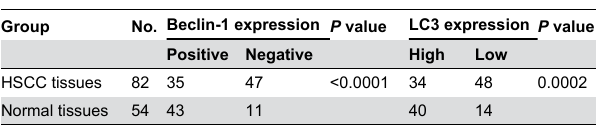
Table 2. Expression patterns of beclin-1 and LC3 in hypopharyngeal squamous cell carcinoma (HSCC) and adjacent non-tumor